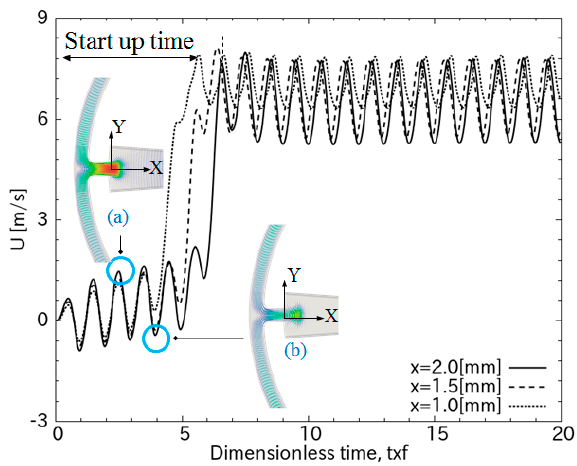
Figure 3. Transient characteristic of the flow in working chamber. The insets show jet flow at the nozzle entering the working chamber in ( a ) the pumping phase and ( b ) the suction phase. The amplitude of diaphragm deflections is 10 μ m.